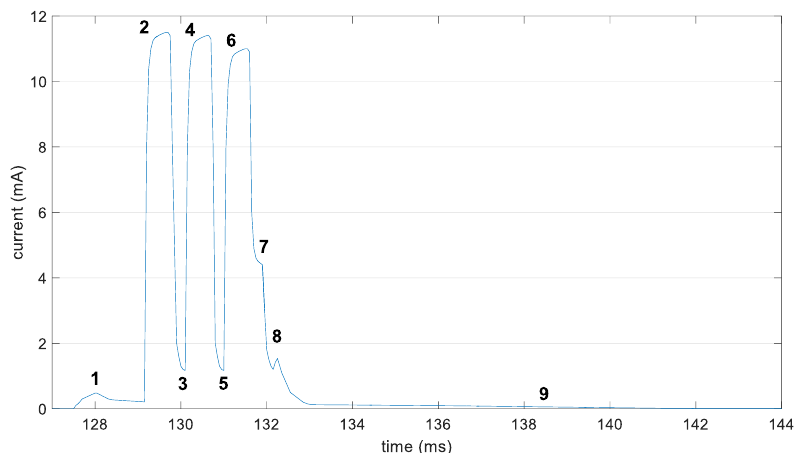
Figure 6. Current consumption of an nRF51422 Development Kit for the different states related with the transmission of three advertisements. Table 1. Characterization of the states related with the transmission of three advertisements by an nRF51422 Development Kit.